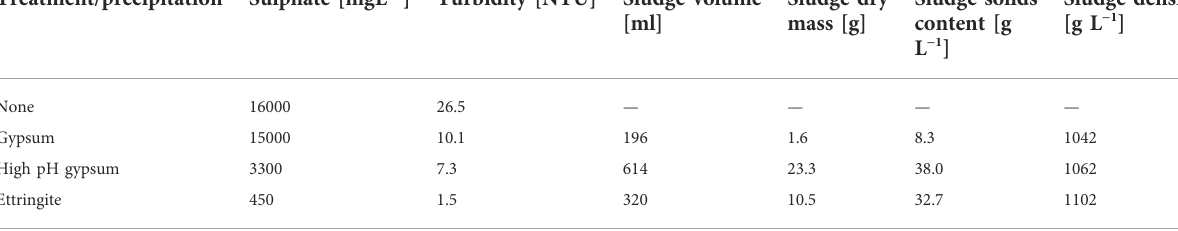
TABLE 3 Properties of the sludge and the industrial wastewater after the gypsum and ettringite precipitation